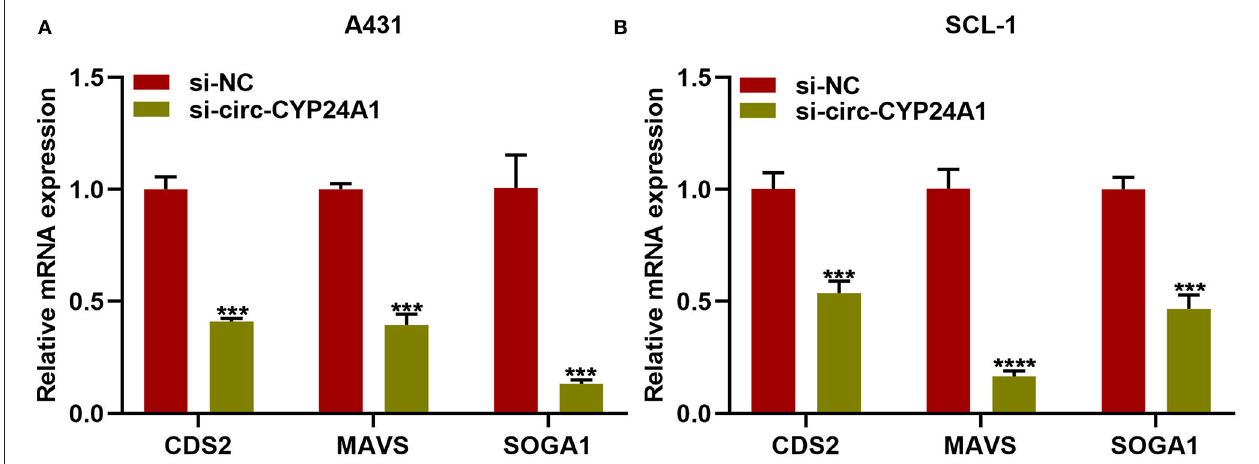
FIGURE 9 | Exosomal circ-CYP24A1 knockdown lowers CDS2, MAVS and SOGA1 expression in cSCC cells. (A,B) RT-qPCR for the mRNA expression of CDS2, MAVS and SOGA1 in (A) A431 cells and (B) SCL-1 cells incubated with si-circ-CYP24A1-transfected exosomes. *** P -value < 0.001; **** p -value <